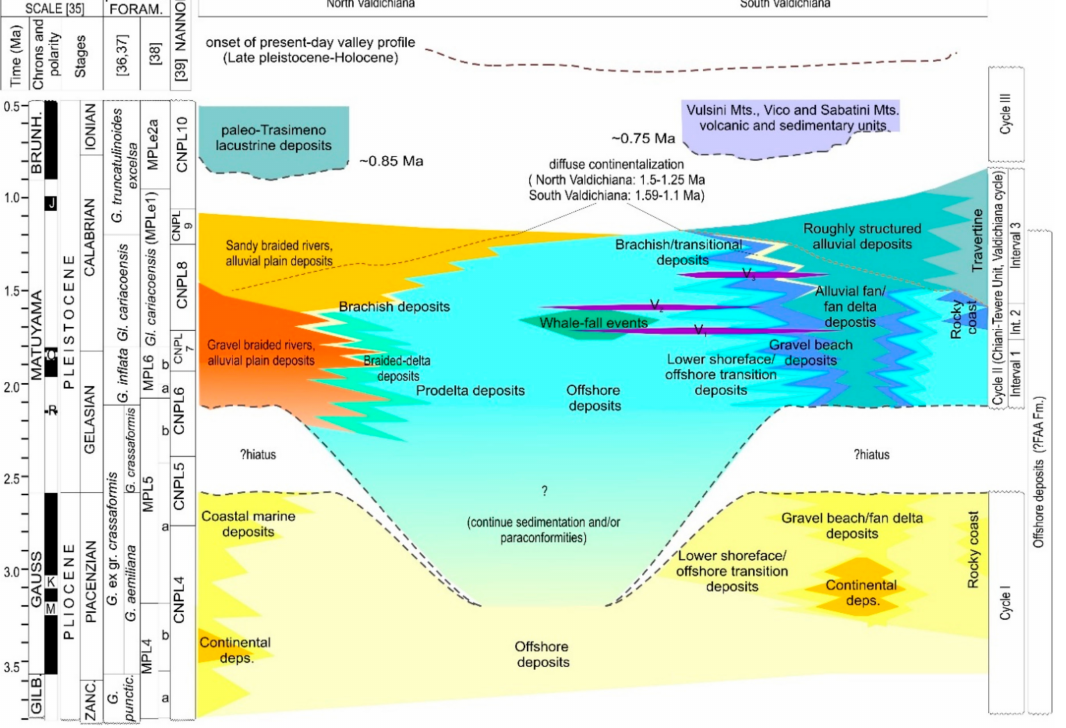
Figure 7. Integrate stratigraphic scheme proposed for the study